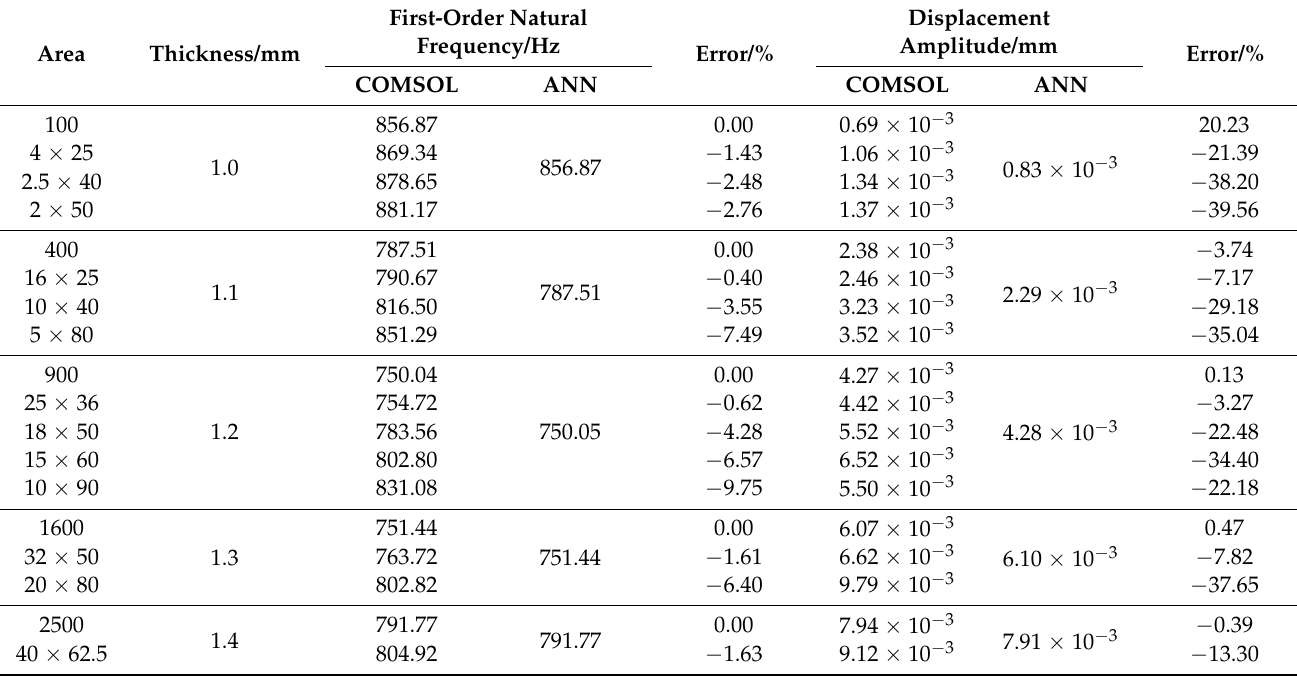
Table 5. Comparison of prediction results of the same area with different aspect